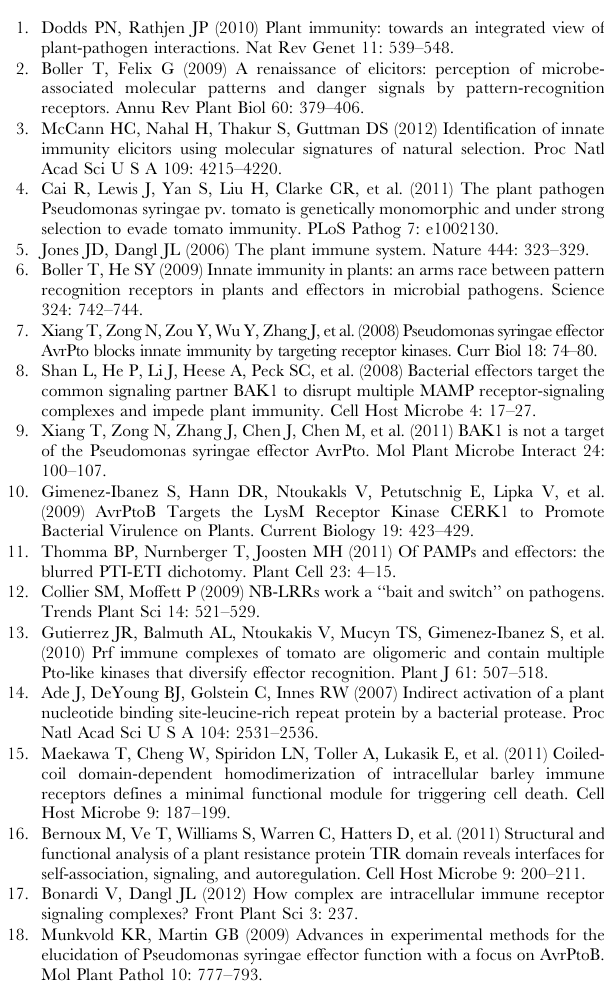
loading. The experiment was repeated several times and typical results are shown. (TIF) Table S1 Double phosphorylation of Pto peptide 187– 202 and 1888-202 upon activation of signalling. Table S2 Double phosphorylation of Pto peptide 187– 202 and 188–202 upon activation of signalling. Table S3 Summary of the different complex combina- tions examined, and their signalling